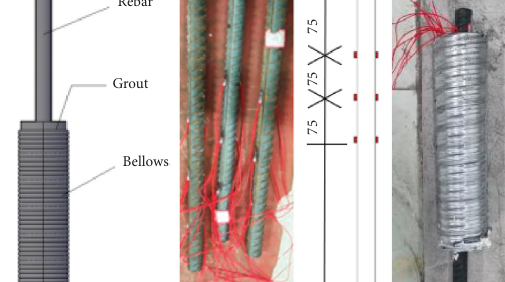
Table 2: Specimen design parameter